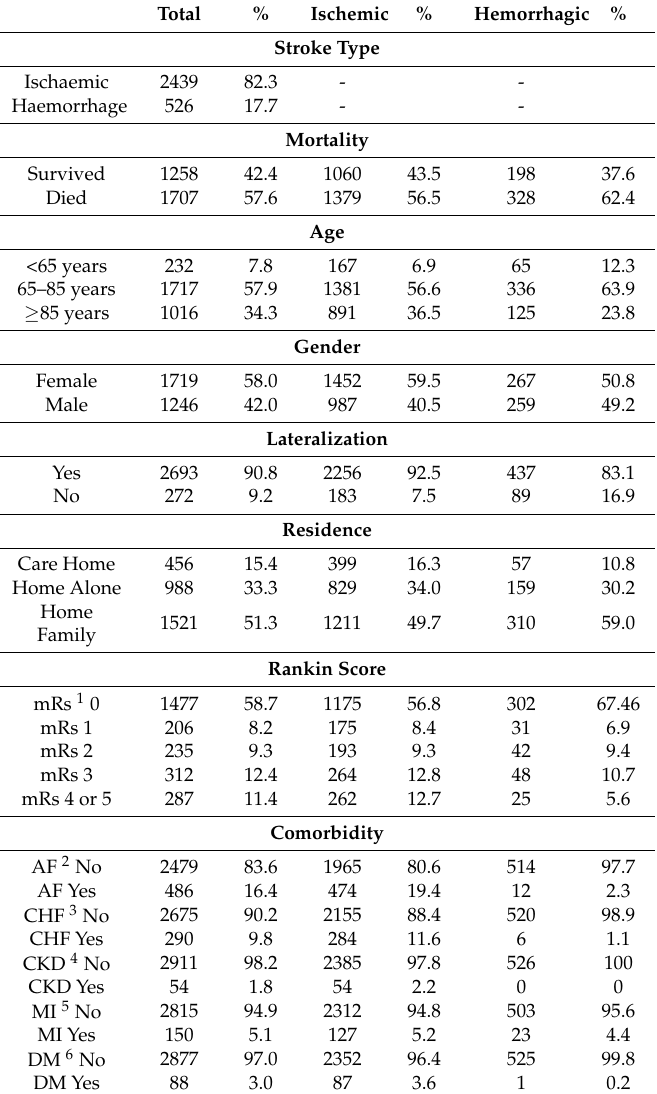
Table 1. Total anterior circulation stroke patient cohort characteristics.